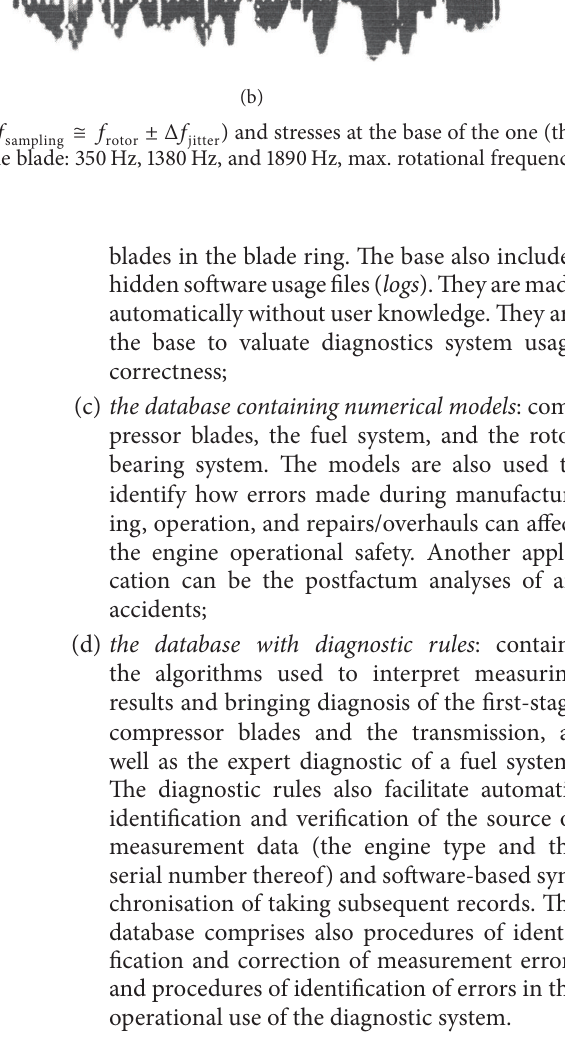
≅ 𝑓 ± Δ𝑓 ) and stresses at the base of the one (the sampling rotor jitter